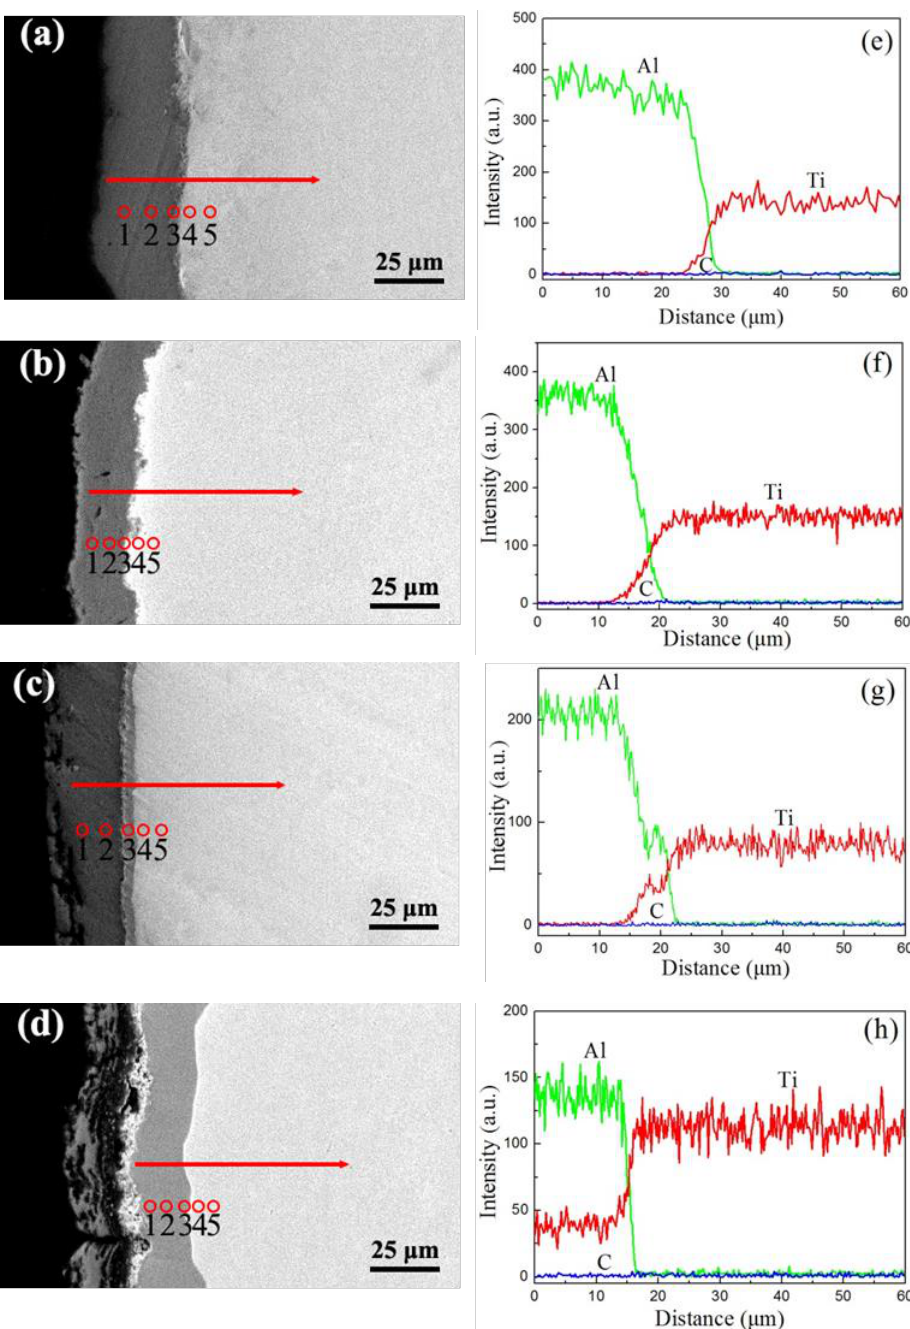
Figure 8. The energy-dispersive X-ray spectroscopy linear scanning and point scanning analysis of the samples: ( a , e ) S1, ( b , f ) S2, ( c , g ) S3, ( d , h ) S4. Table 4. Chemical composition (at.%) in positions 1 – 5 as shown in Figure 8a – d, obtained from the energy dispersive X-ray spectrometer (EDS) analysis.